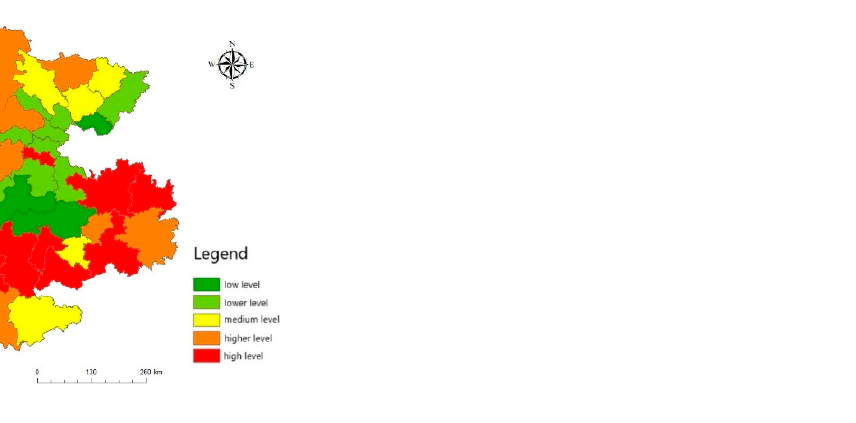
Figure 4. Spatial distribution of the tourism development level: ( a ) The tourism development level in 2010; ( b ) The tourism development level in 2013; ( c ) The tourism development level in 2016; ( d ) The tourism development level in 2019; ( e ) The tourism development level in 2020.